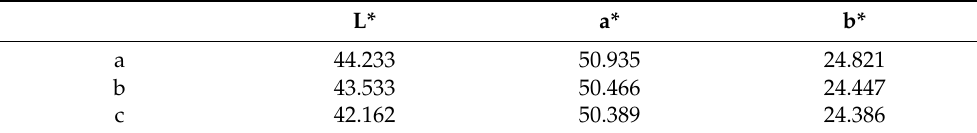
Figure 11. Reflectance spectra of (a) Original red paper; (b) Modified red paper; (c) Red modified paper that has been soaked many times. Table 1. The L *, a *, and b * values of a , b , c